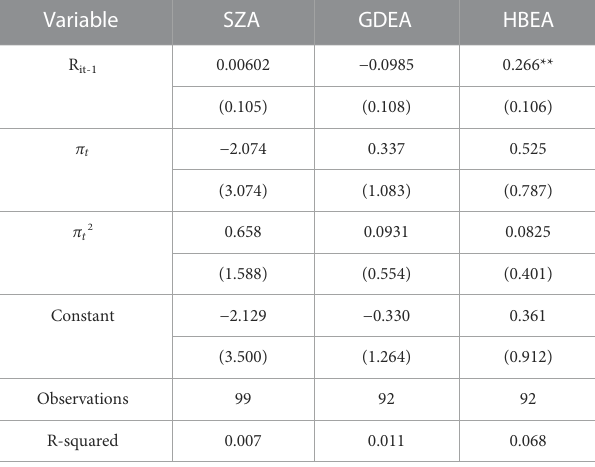
TABLE 4 Regression results of carbon price growth rate and squared in fl ation. Variable SZA GDEA